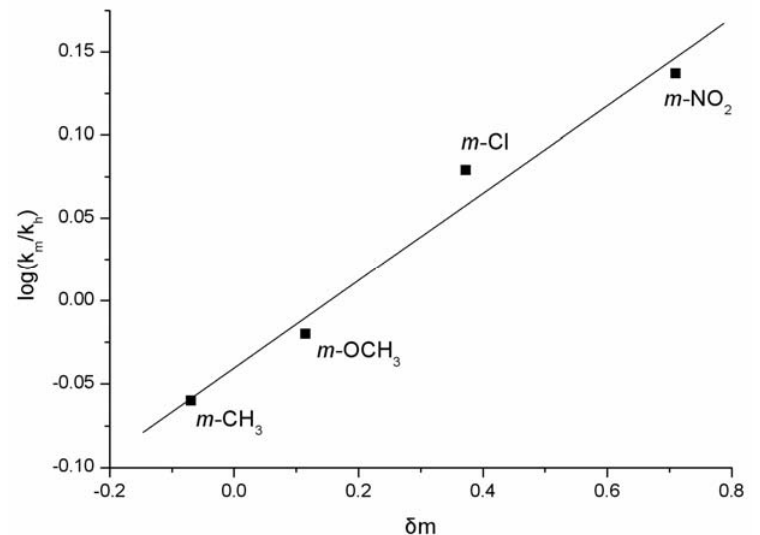
Figure 1. Hammett plot for C-3 substituted